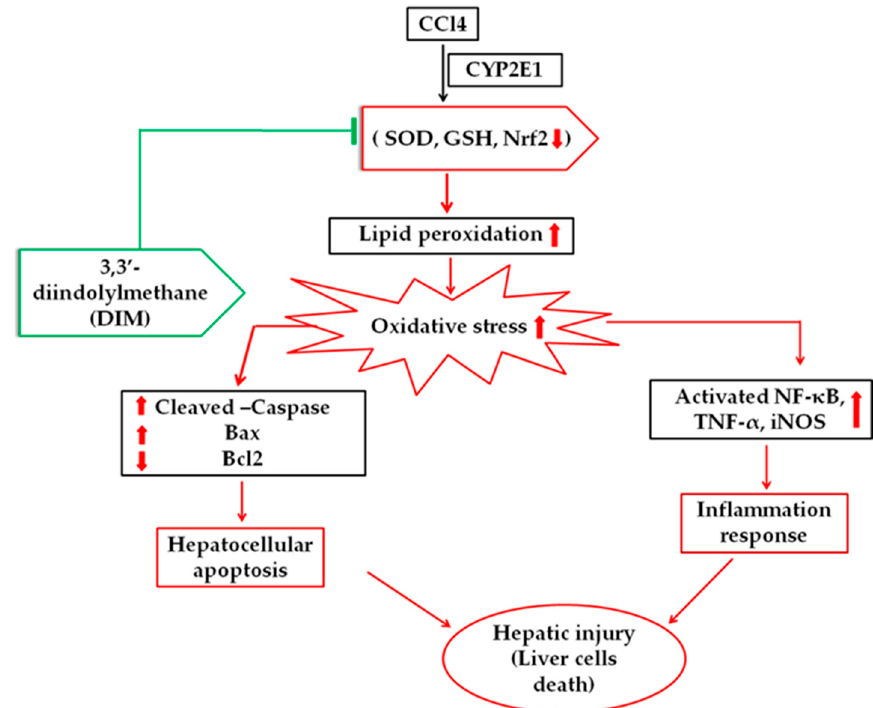
Figure 8. A schematic diagram of the proposed mechanisms by which DIM inhibits CCl 4 –induced oxidative stress, reduces inflammatory response and inhibits apoptosis by regulating oxidative stress and caspase-3,9/Bax/Bcl2 pathways. In the figure downward red arrow shows CCl 4 – induced liver injury decreases antioxidants ability (SOD, GSH, Nrf2) and anti-apoptotic proteins levels Bcl2 whereas upward red arrow shows increased inflammatory responses, oxidative stress and apoptotic proteins, which were altered by DIM pretreatment.